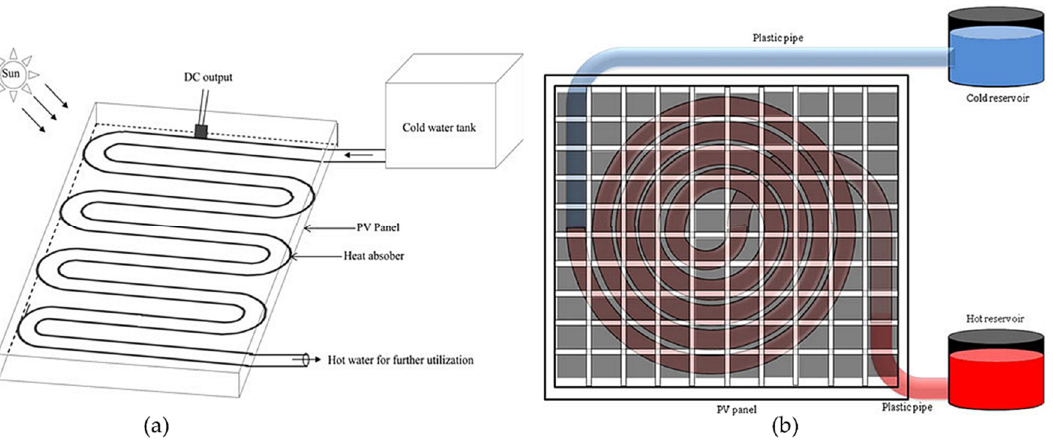
Figure 10. Experimental arrangement of PVT ( a ) semioval serpentine and ( b ) circular spiral. Reprinted with permission from Ref. [106]. 2018. Bhattacharjee et al.